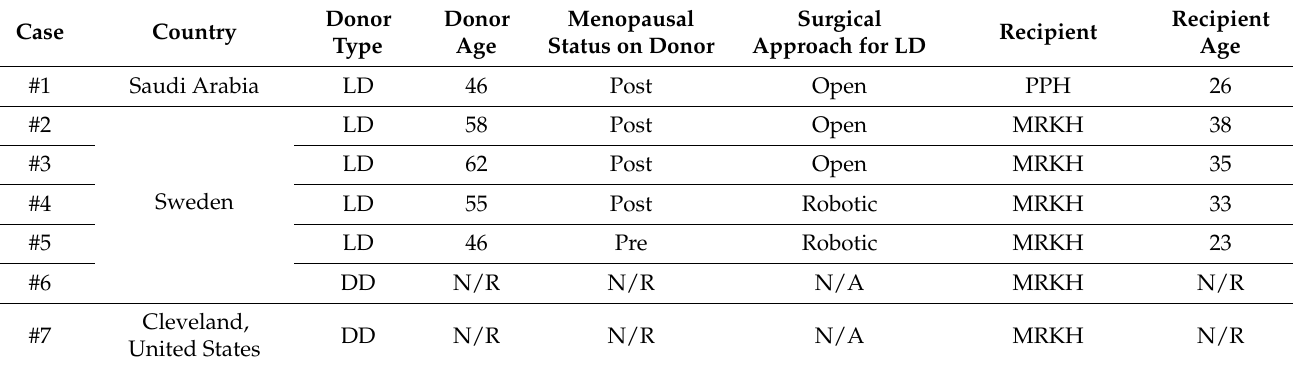
Table 2. Characteristics of recipients and donors for uterus